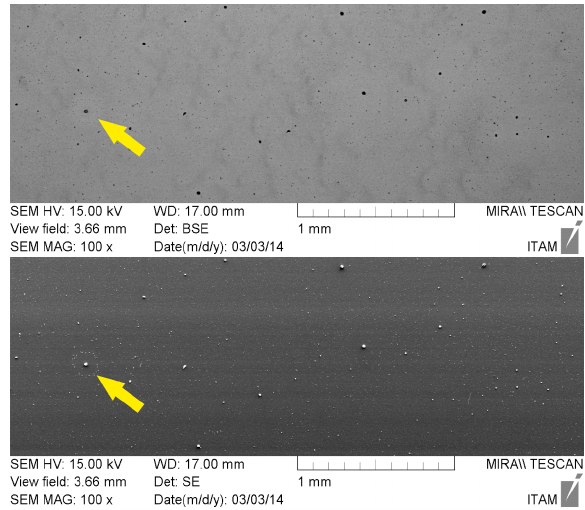
Figure 3. SEM image of the unweathered coating using (a) the BSE detector and (b) the SE detector.